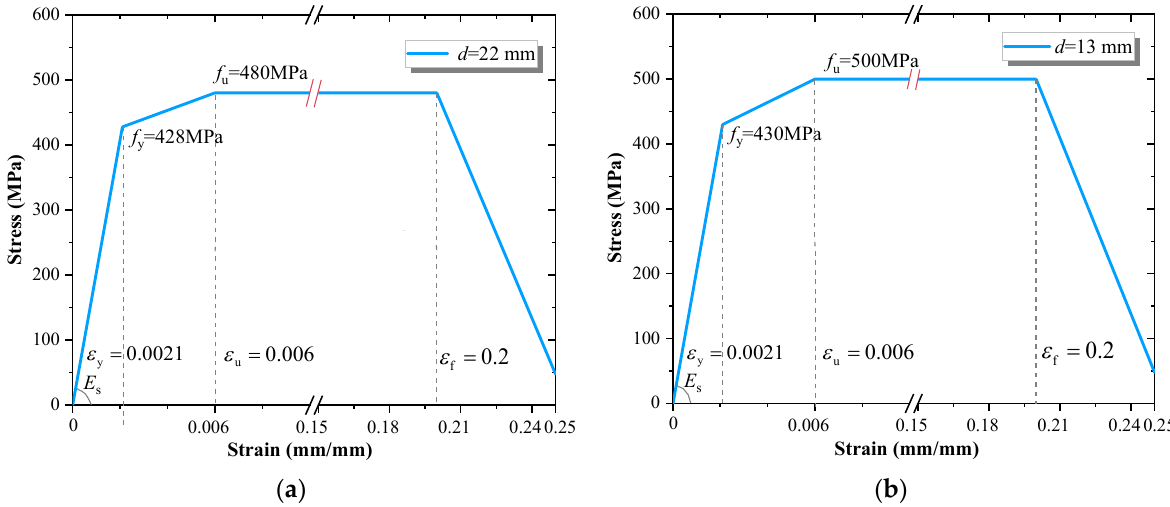
Figure 6. Constitutive relationship of headed studs: ( a ) studs with 22 mm diameter; ( b ) studs with 13 mm diameter.